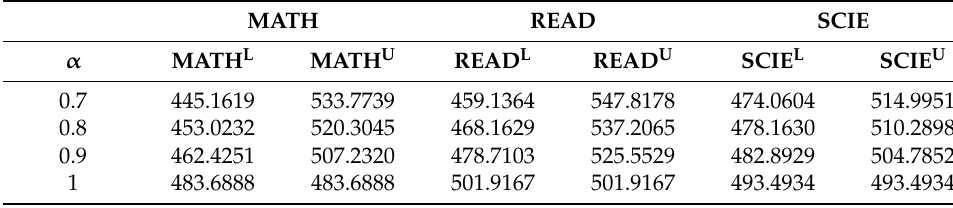
Table 2. α -cuts for student 1635 (randomly selected).